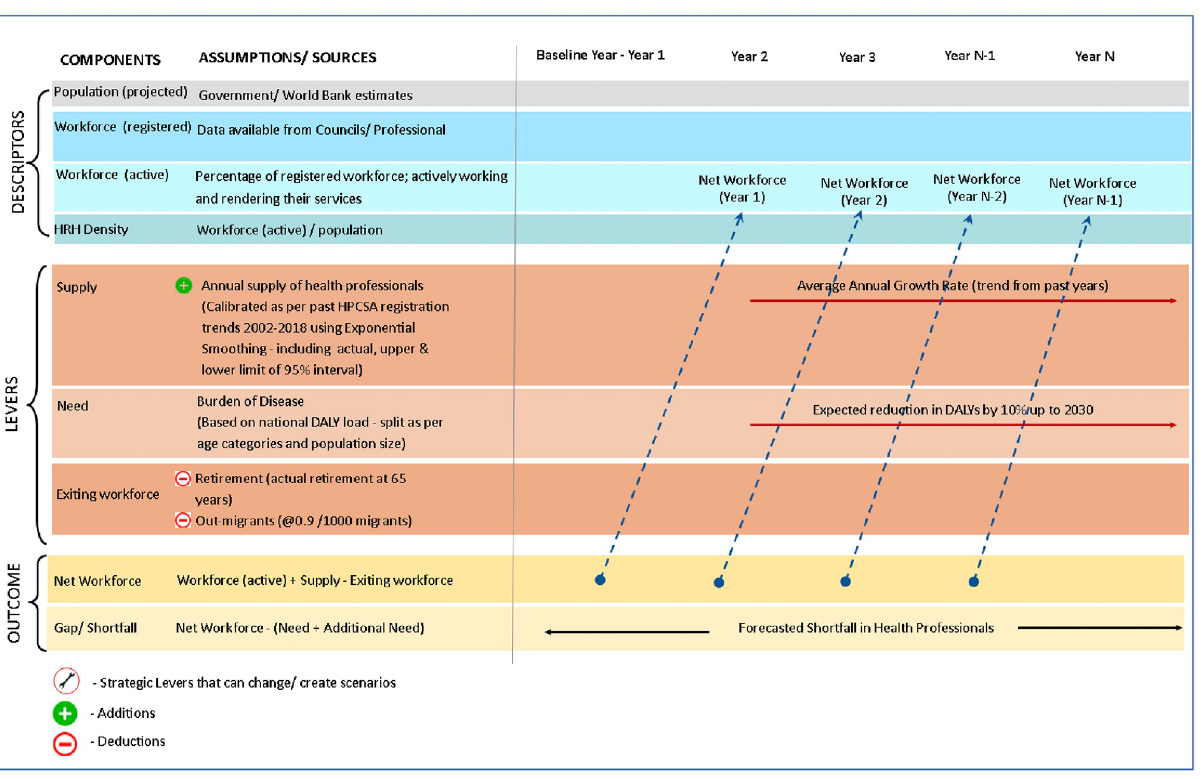
Fig 1. Workforce projection model.